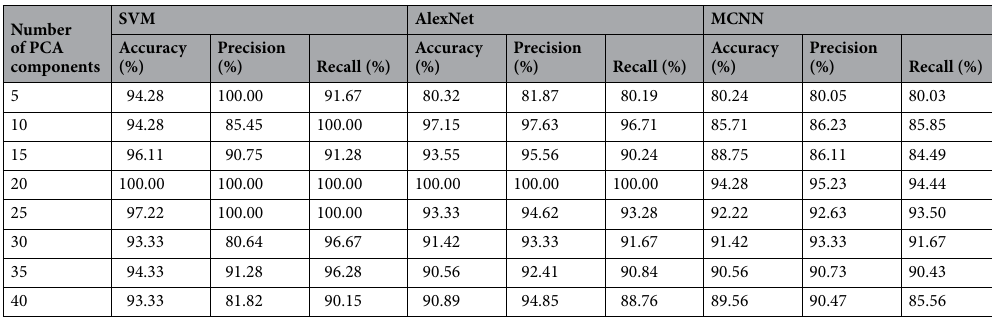
Table 2. Test set experimental results of SVM, AlexNet and MCNN.